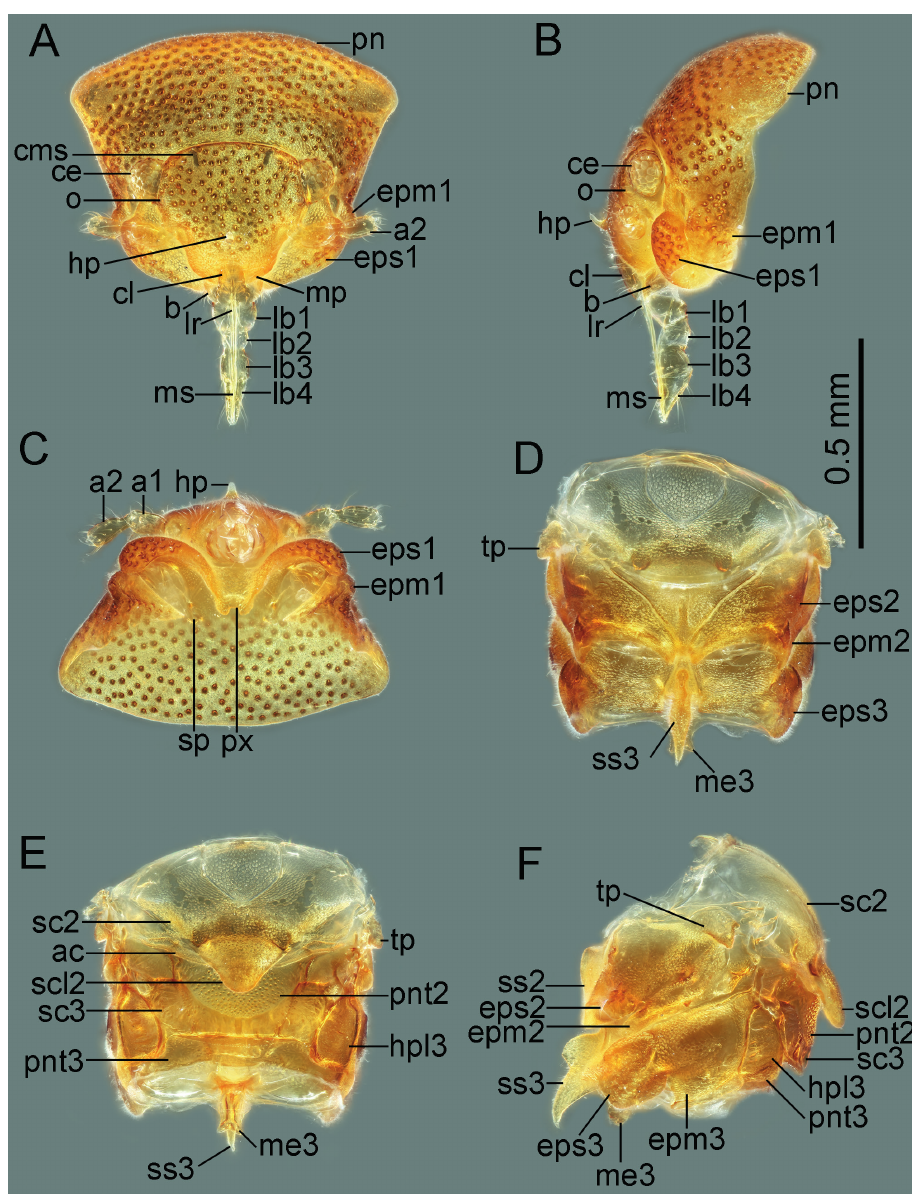
Figure 2. Head and thorax of Cornonannus bui gen. et sp. nov., male paratype A–C male head and prothorax D–F male pterothorax A in frontal view B in lateral view C in ventral view D in ventral view E in dorsal view F in lateral